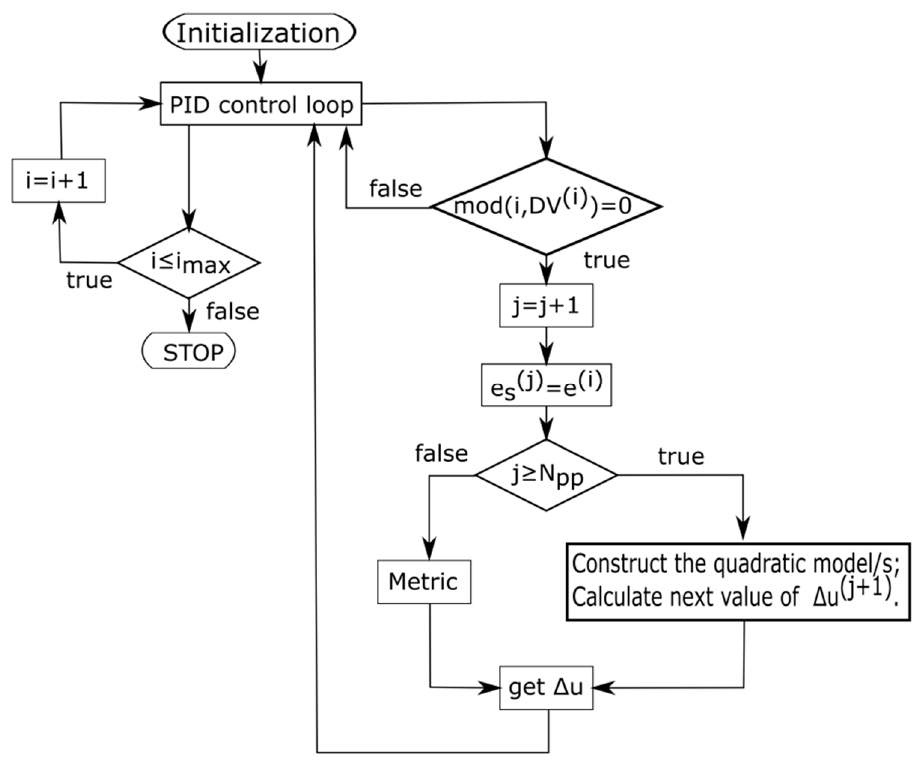
Figure 3. The flow chart diagram of the DUPID controller.